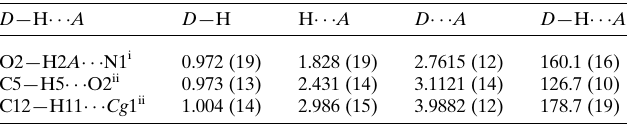
Table 1 Hydrogen-bond geometry (A˚ , (cid:3) ). Cg 1 is the centroid of the C1–C6 benzene ring.